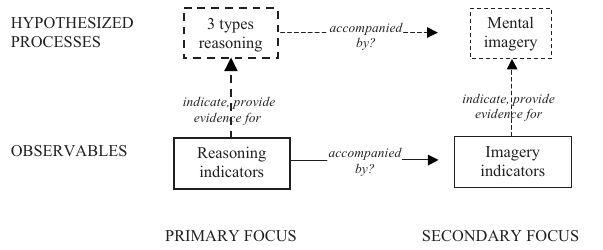
FIG. 1. Relationships among observables and hypotheses in